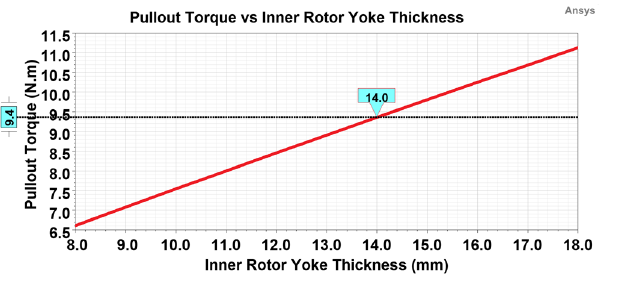
Figure 10. Inner and outer rotor PM thickness versus: ( a ) Torque density; ( b ) Coupler weight.